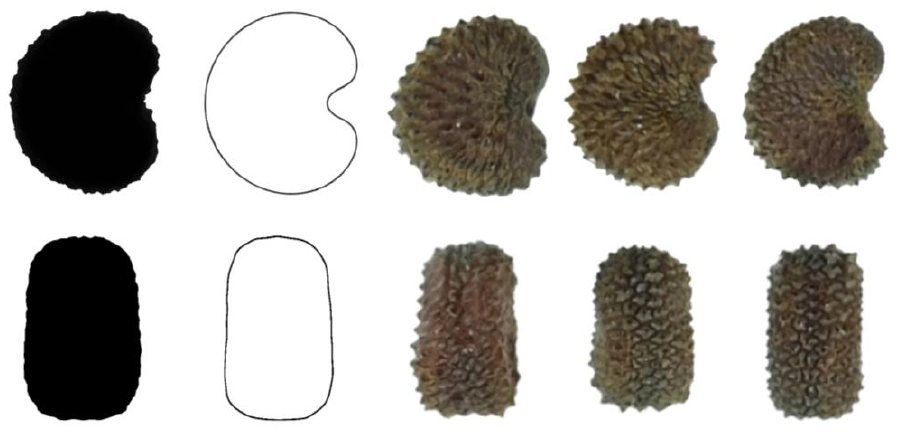
Figure 19. Silene multiflora : average silhouettes (left), the models giving best scores with 20 seeds (LM8 and DM10), and three representative images for the lateral (above) and dorsal (below) seed views. Bar represents 1 mm.